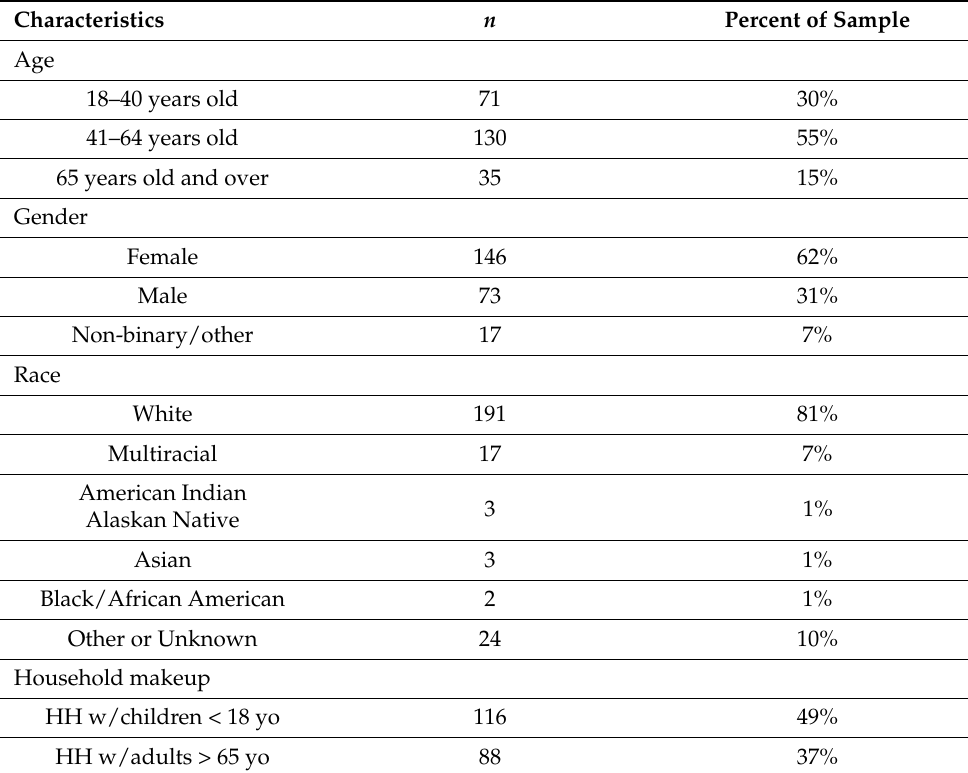
Table 1. Demographic characteristics of respondents ( n =